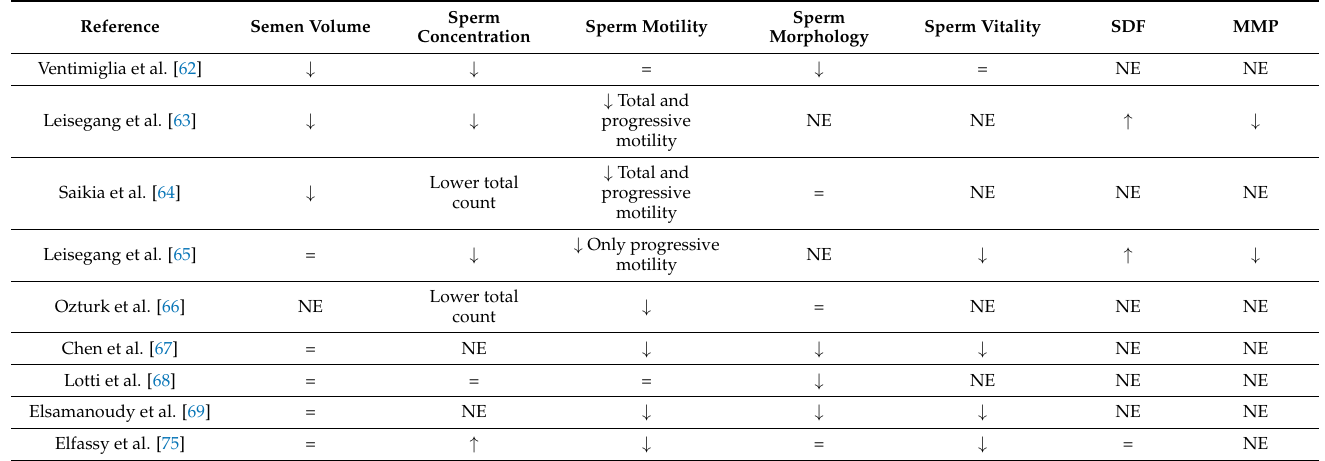
Table 2. Standard semen parameters: comparison of MetS versus no-MetS